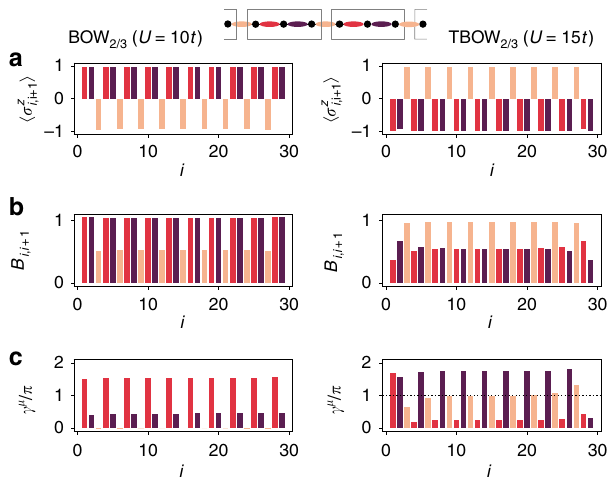
Fig. 2 Simultaneous orders in intertwined topological phases: real-space i and ( b ) the bosonic bond densities con fi guration of ( a ) the Z 2 fi eld h σ z i ; i þ 1 ¼ h b y b i þ c : c : , using different colors for each element of the unit B i ; i þ 1 i þ 1 i cell at β = 0.01 t . Different permutations within the unit cell lead to a threefold quasi-degenerate ground state, each obtained from one another by translating the modulation patterns of the ferrimagnetic and BOW orders. The quasi-degeneracy comes from the fi nite-size effects, but degeneracy is recovered in the thermodynamic limit. c ) The local Berry phases γ μ display a quantized value of 0 ( U = 10 t ) or π ( U = 15 t ) on the bonds preserving the inversion symmetry of the unit cell, allowing us to distinguish between the trivial and topological BOW phases. We note that the topological BOW phase (right panels) does not have a fermionic analog 48 in the ground state of the SSH model 32,33 , which instead realizes the trivial BOW (left panels) for energetic